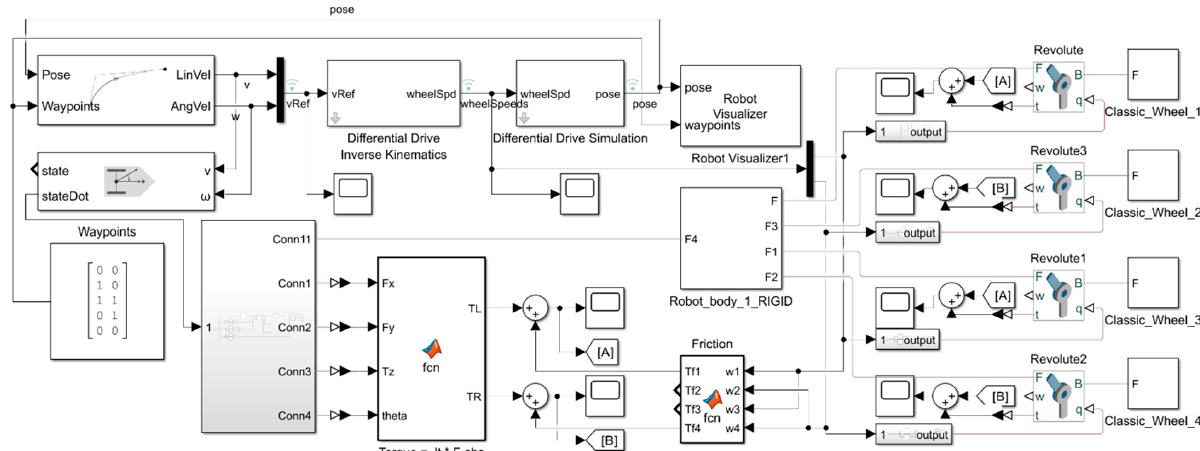
Figure 26. Dynamic model of the mobile robot—block diagram.